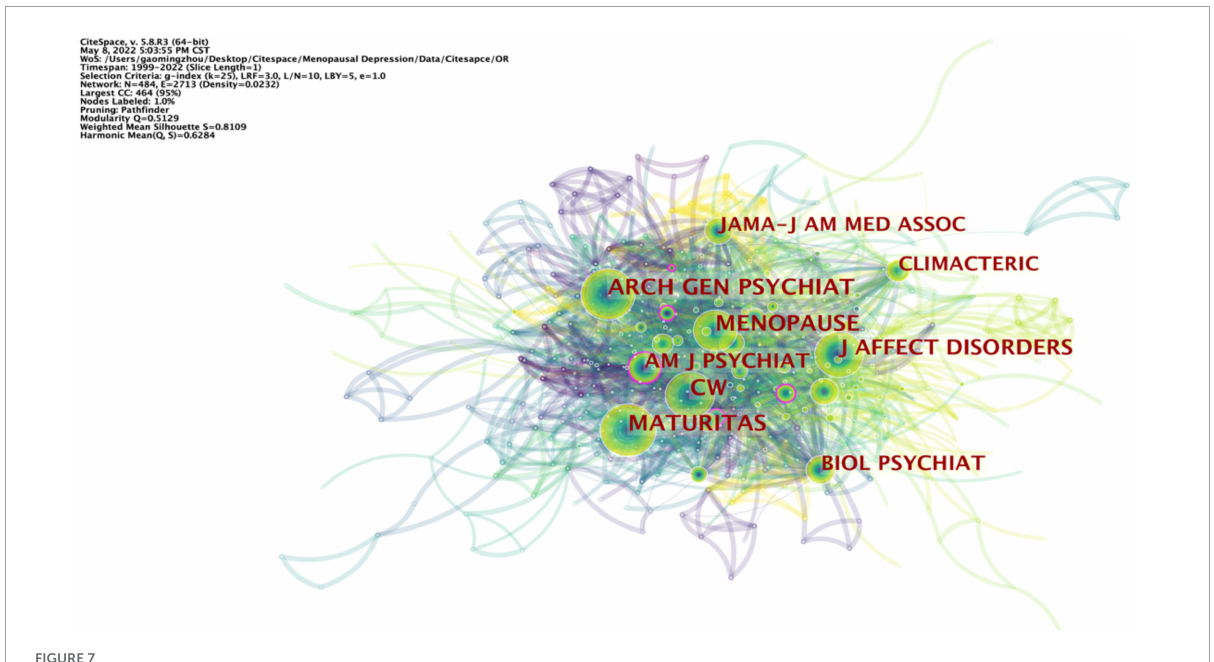
FIGURE7 Visualization map of journals on PMD.